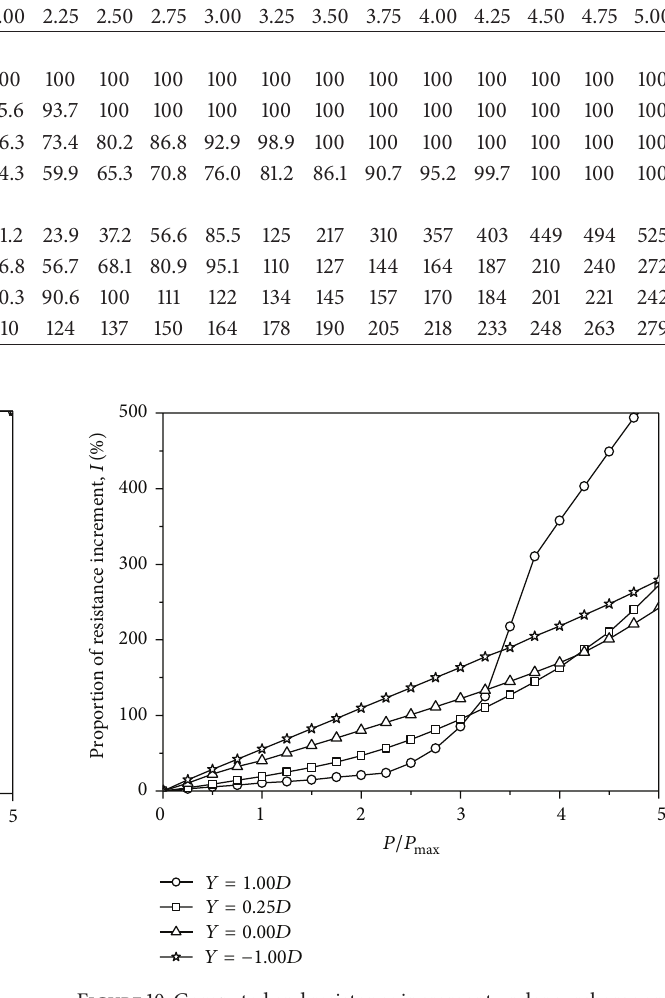
Figure 9: Computed maximum dragload reduction under sur- charge and axial loads.